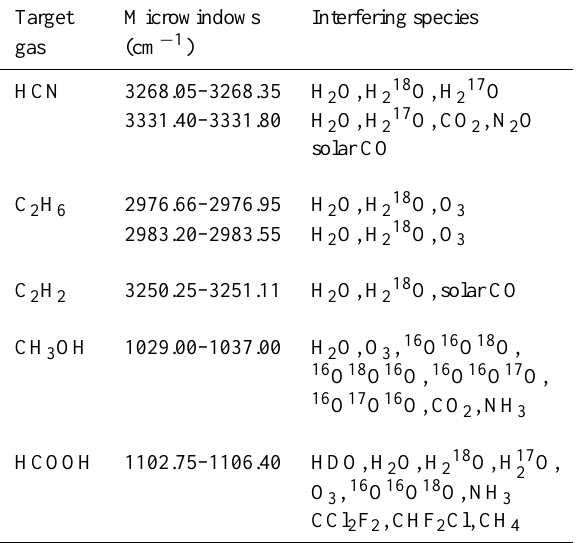
Table 1. Microwindows (in cm − 1 ) and interfering species used for the retrievals of HCN, C 2 H 6 , C 2 H 2 , HCOOH, and CH 3 OH. Target